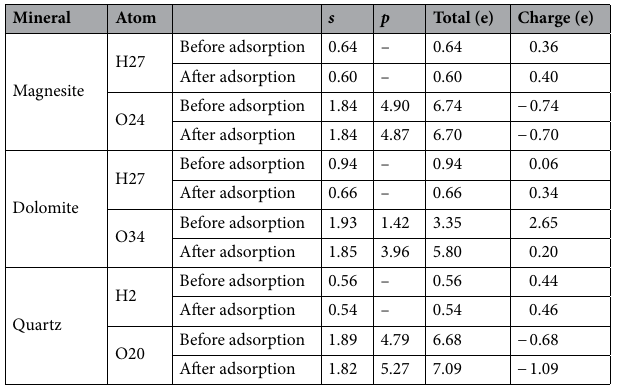
Table 3. DDA Mulliken population analysis on the surface of Magnesite (101), dolomite (101) and quartz